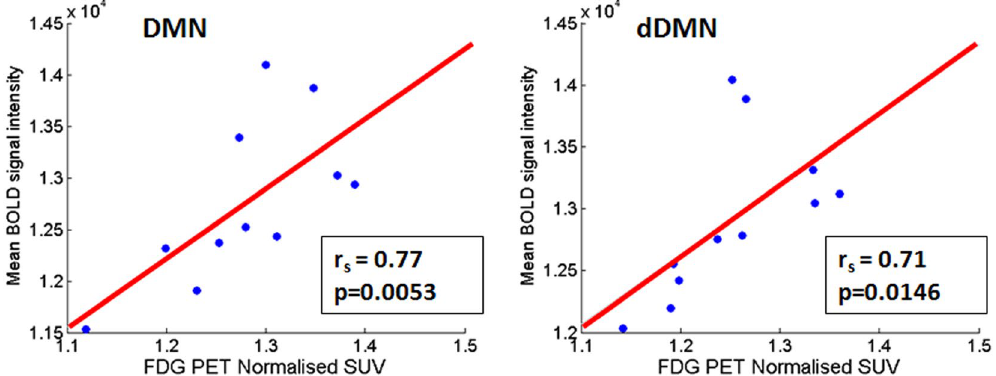
Figure 8. Correlation plot between normalised SUV uptake of FDG PET and BOLD signal intensity in DMN (right side) and dDMN (left